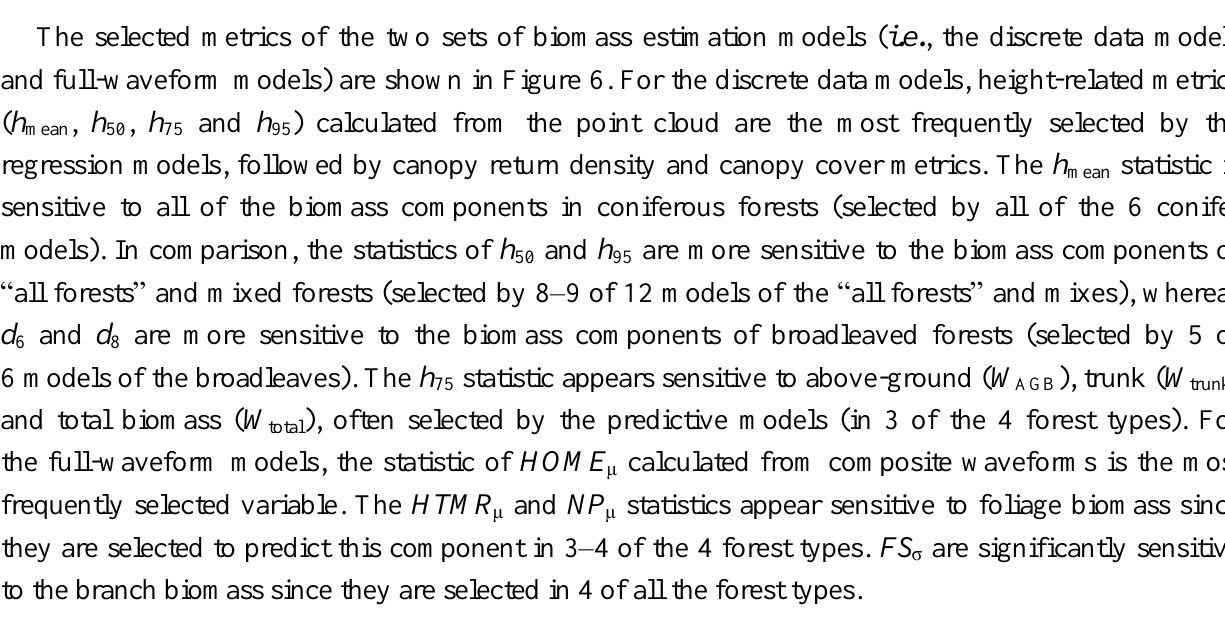
Figure 6. The selected LiDAR metrics of the discrete data model vs. full-waveform model in various forest